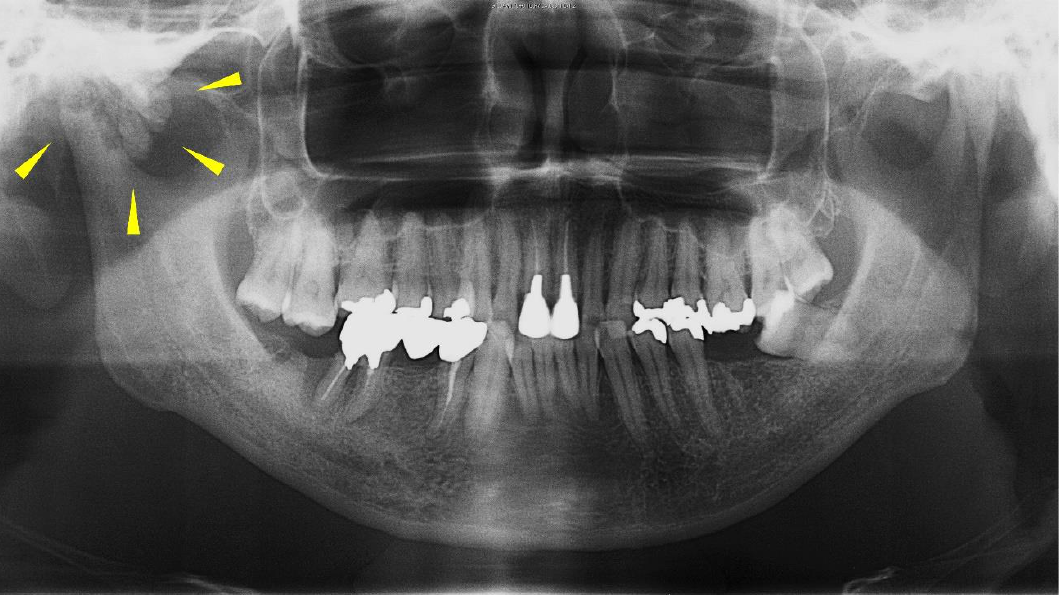
Figure 1. Panoramic radiograph from the first visit. The ill-defined calcification around the mandib- ular condyle is shown (yellow arrows).